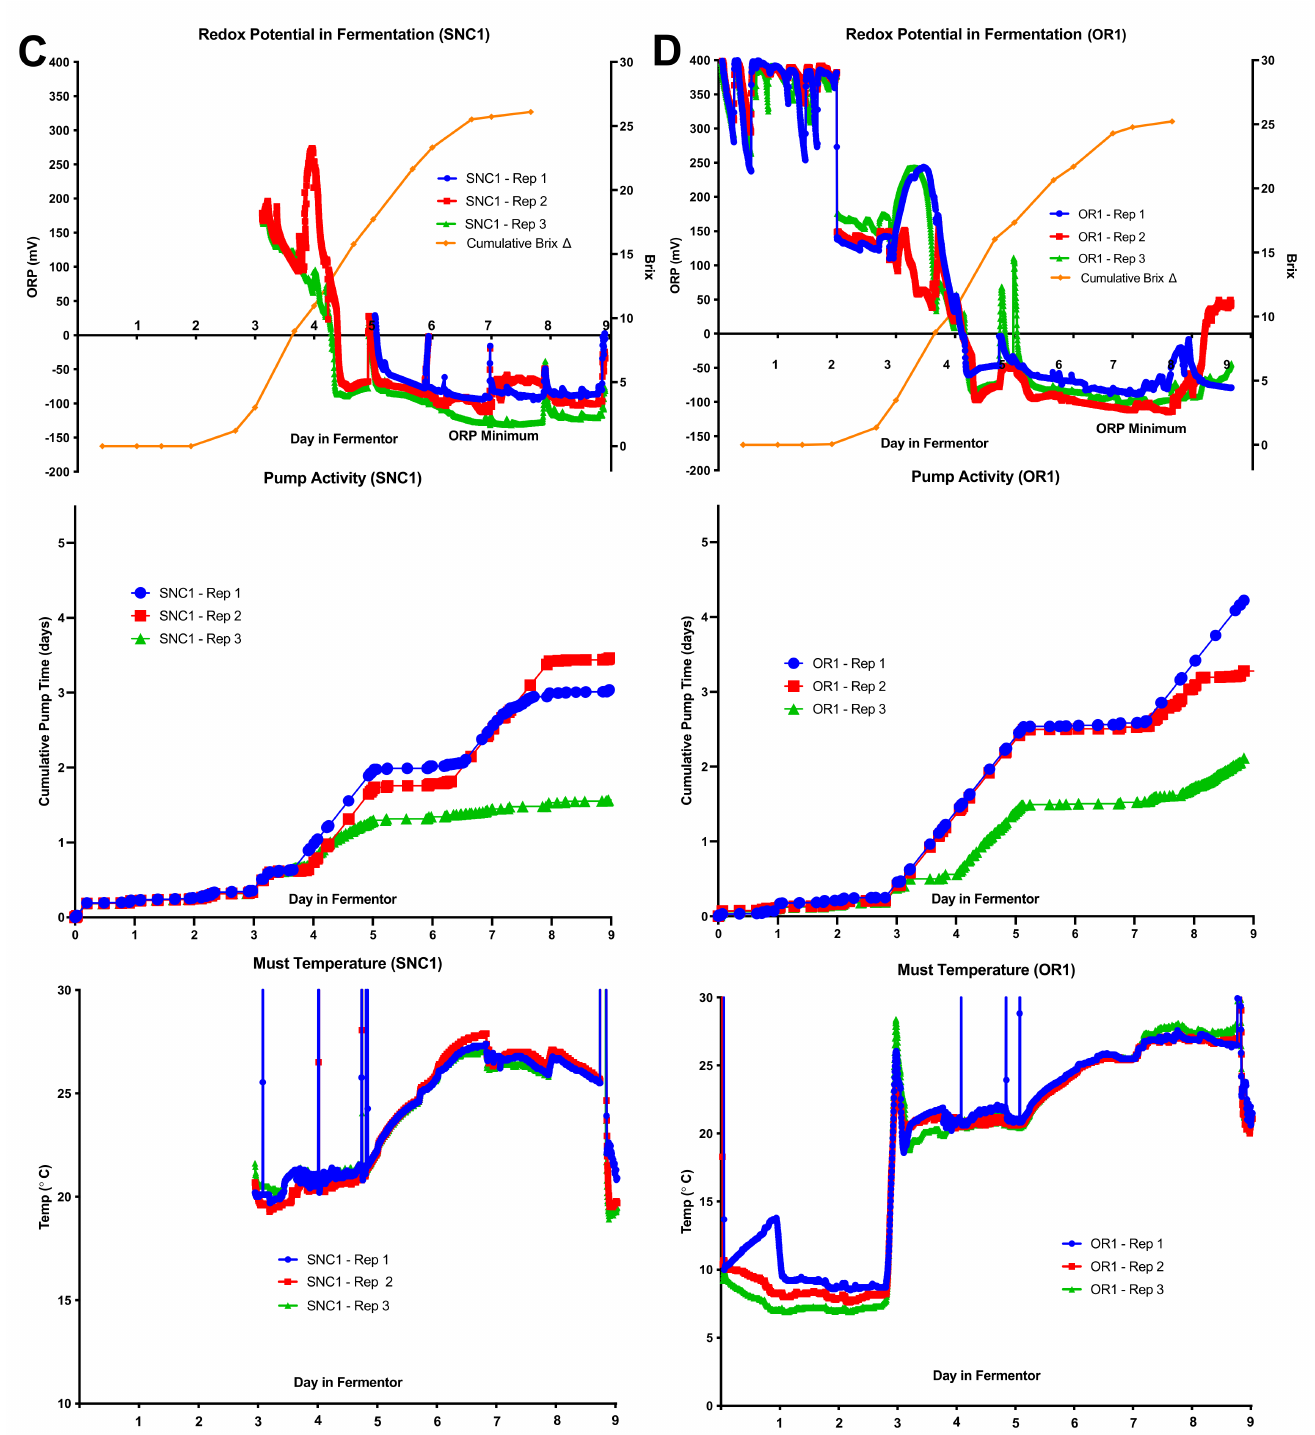
Figure 4. ( A ) Individual Redox Potential (ORP) profiles, cumulative pump activity, and must temperature profiles for the AS2 replicates. The AS2 replicates displayed the fastest and more reproducible fermentation profiles. ( B ) Individual Redox Potential (ORP) profiles, cumulative pump activity, and must temperature profiles for SMV2 replicates. SMV2-Rep 2/3 display a spike in ORP on day 6, corresponding with manual manipulation of these probes as they were lifted out of the fermentor for maintenance. ( C ) Individual Redox (ORP) profiles, cumulative pump activity, and must temperature profile for SNC1 replicates. SNC1-Rep 1/2 display a spike in ORP on day 6, corresponding with manual manipulation of these probes as they were lifted out of the fermentor for maintenance. ( D ) Individual Redox Potential (ORP) profiles,